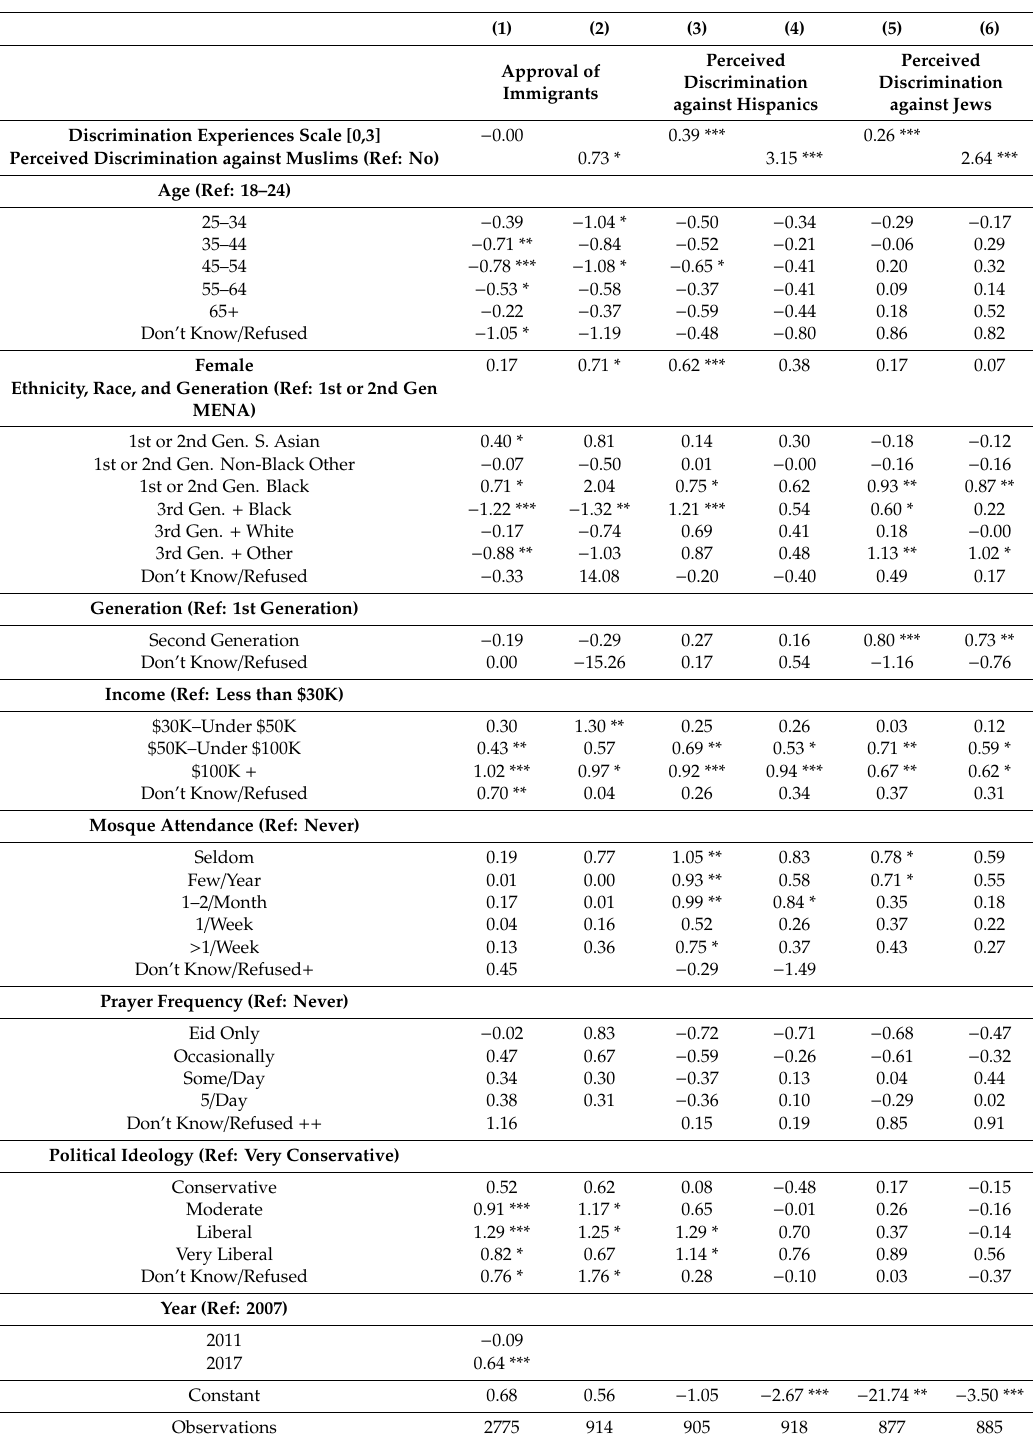
Table 4. Coe ffi cients from Logistic Regression Predicting Solidarity with Immigrants, Hispanics and